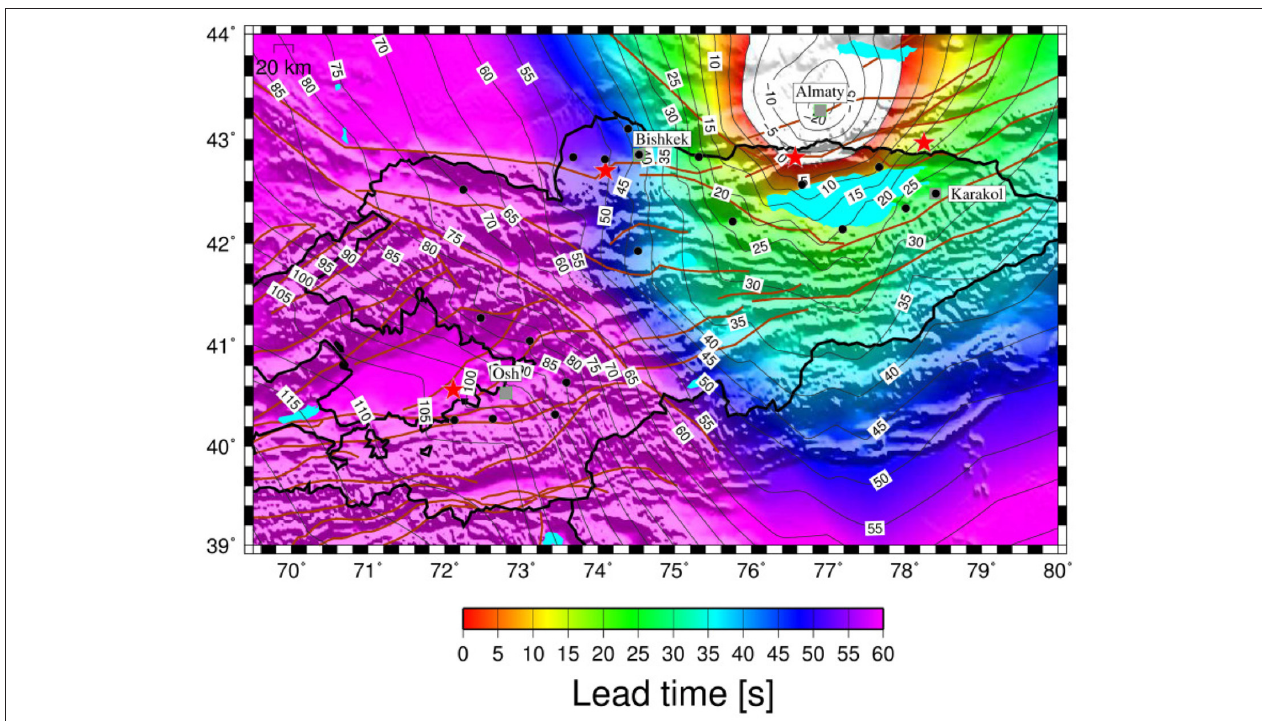
FIGURE 10 | The lead-time for Almaty, using a regional approach, as a function of the location of possible seismic events i.e., a 0.1 by 0.1 ◦ grid. Also shown are the main cities considered in this study (gray squares) and a selection of historical or hypothetical earthquakes (red stars, see Figure 1 and text for explanation). The brown lines indicate the main tectonic alignments and faults existing in the area.